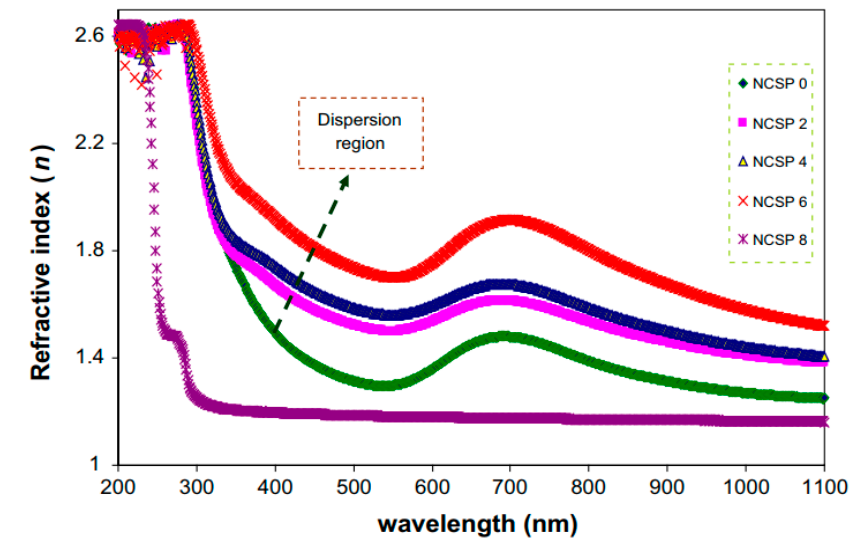
Figure 26. Pure and doped PMMA refractive index. The samples were symbolized as NCSP0, NCSP2, NCSP4, NCSP6 and NCSP8 for PMMA with 0 wt%, PMMA with 2 wt%, PMMA with 4 wt%, PMMA with 6 wt% and PMMA with 8 wt% of CuS, correspondingly [139].